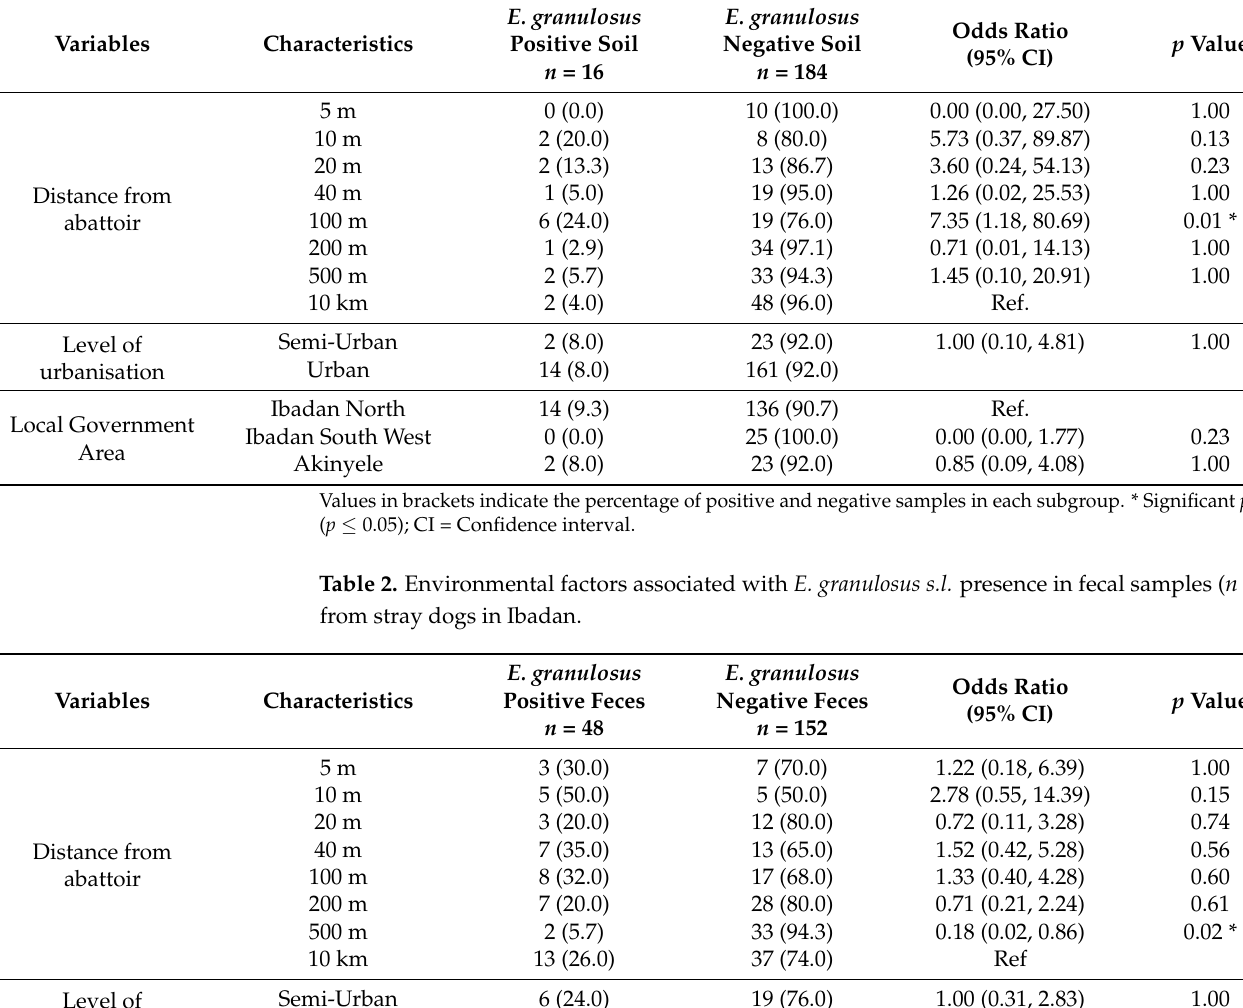
Table 1. Environmental factors associated with E. granulosus s.l. presence in soil samples ( n = 200) from open fields in Ibadan.